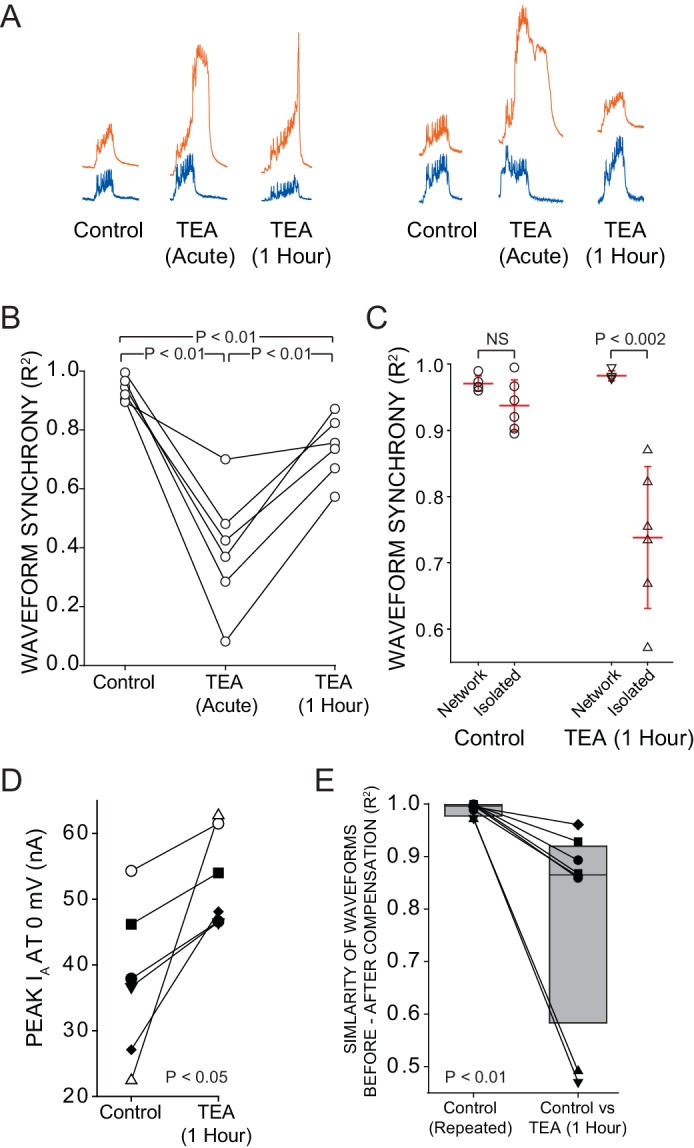
Intrinsic compensation involving GA partially restores synchrony after TEA block.A reversible sucrose block was used to temporarily stop network activity and a current stimulus protocol was delivered to individual LCs at three time points: control, after 5 min of TEA perfusion (acute), and after 1 hr of TEA perfusion (after compensation). (A) Representative traces from 2 different preparations compare the responses of LC3 (orange) and LC5 (blue) to the same current injection (Stimulus Protocol) at each of the three time points. (B) R2 values for N = 6 preparations at each time point are plotted with the same preparation connected across time points. All 3 conditions were significantly different from one another (p<0.01; paired t-tests). (C) When isolated cell output was compared with the output in the network, there was no difference in R2 at the control state, but following 1 hr of compensation in the network, there was a significant (p<0.002 – t-test) difference in synchrony scores (mean ± SD) between cells when isolated vs. when they are in the intact network. (D) IA was measured by two-electrode voltage clamp before and after compensation in N = 6 LCs in the intact CG. Voltage clamp data were obtained by temporarily silencing network activity with 750 mM sucrose. There was a significant increase in IA after 1 hr in TEA (mean 56 ± 65% increase, p<0.05 –Wilcoxon signed rank test). (E) Similarity of waveform in the same neurons before and after 1 hr TEA exposure. R2 values were calculated for the output of the same cells before and after TEA exposure, and are shown as before-and-after values in the same cell connected by a line. Box plots show distributions of R2 values from cross-correlation analysis of LC voltage waveforms N = 8 cells. Lines within boxes mark the median, box boundaries represent 25th and 75th percentiles. 'Control' is the comparison of voltage waveforms to 2 separate rounds of current injection in the absence of TEA. Although there was improvement in similarity of waveforms after 1 hr in TEA (panel A), the newly compensated output after 1 hr of TEA exposure does not recapitulate the original response to the stimulus protocol (significantly different from control; p<0.01 – Wilcoxon signed rank test).